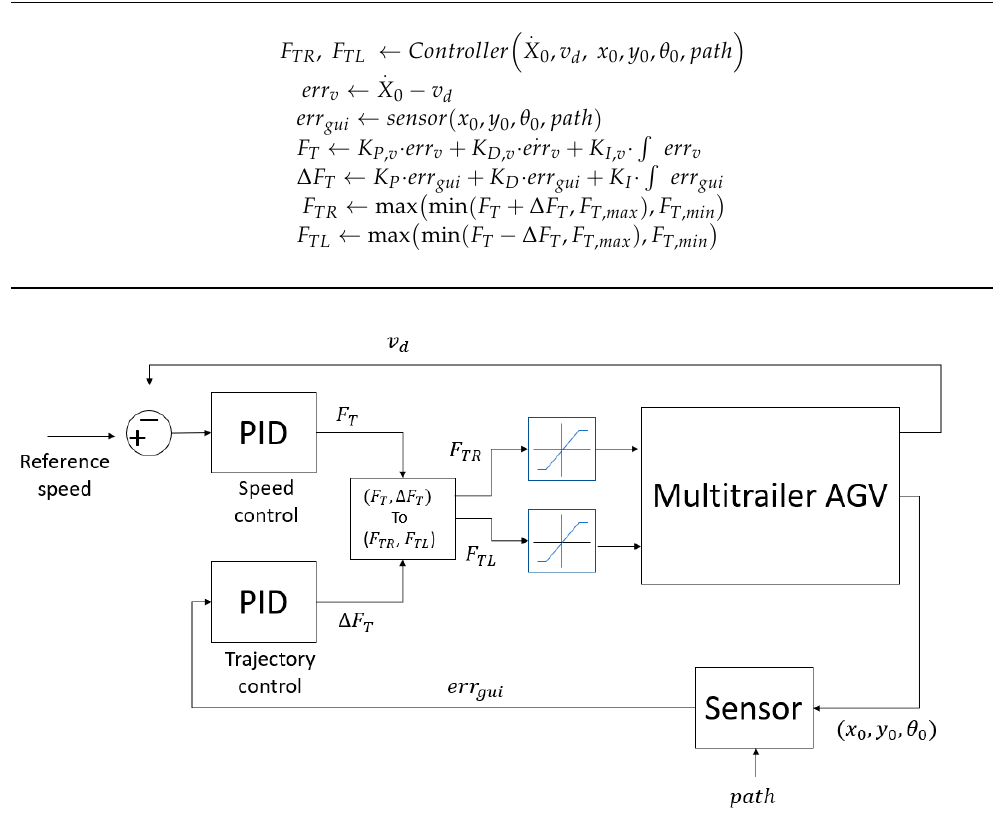
Algorithm 2. Simple PID controller to test the modelling approach.